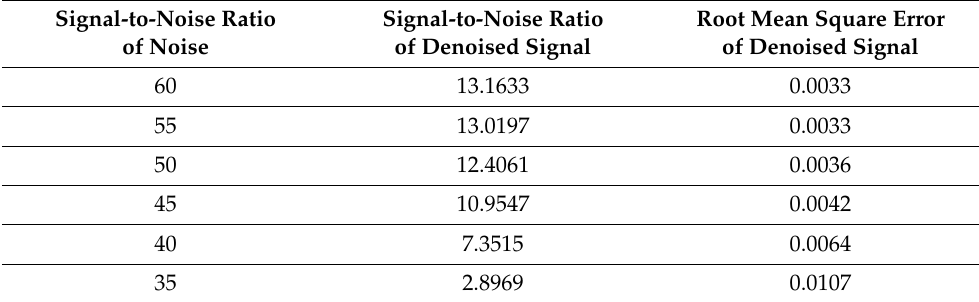
Table 2. The denoising effect of CEEMD-BF under different